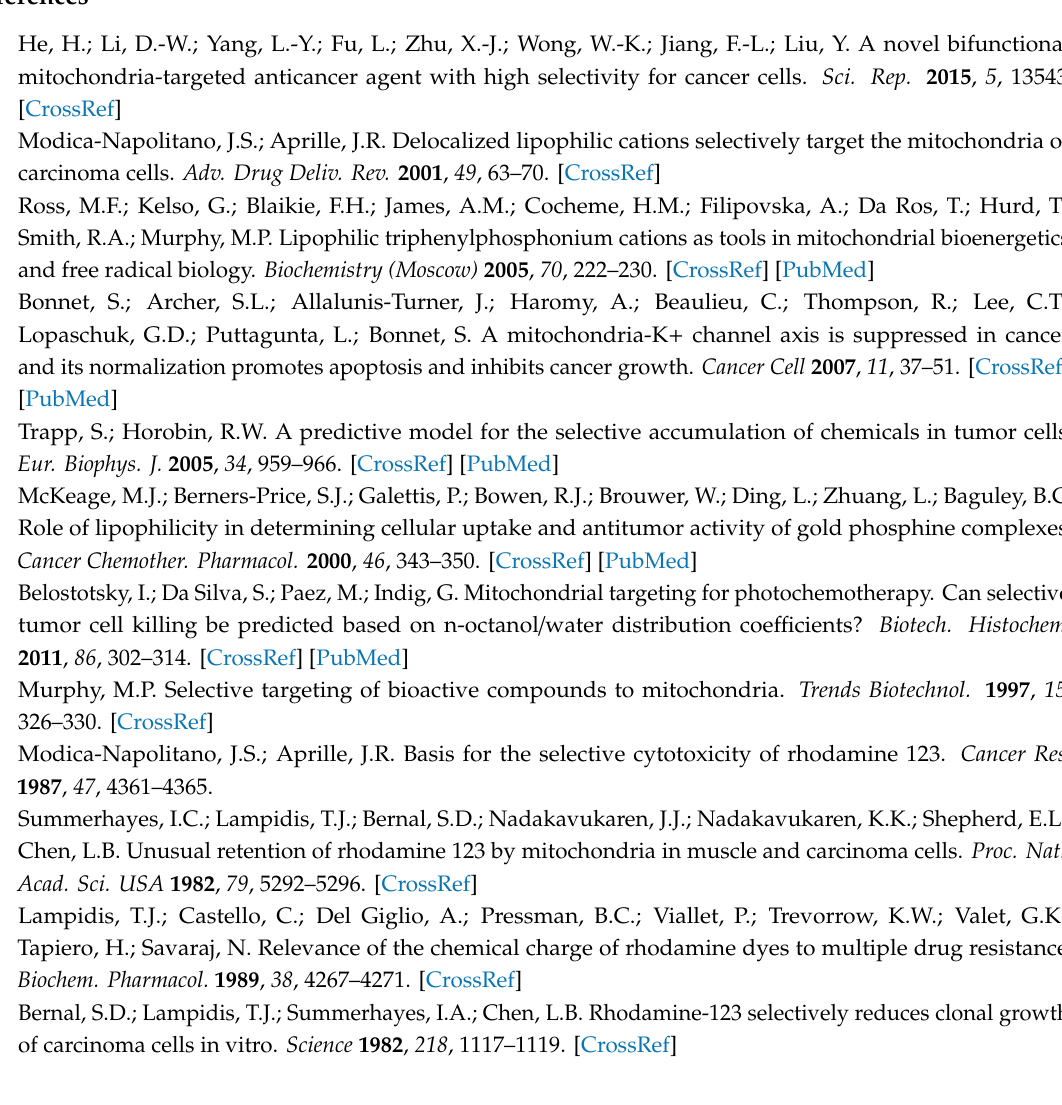
Supplementary Materials: The following are available online. Table S1: Results from ESI mass spectrometric characterization of GUMBOS. Table S2: Relative hydrophobicity of R123 and SNAFR-5 based GUMBOS; Figure